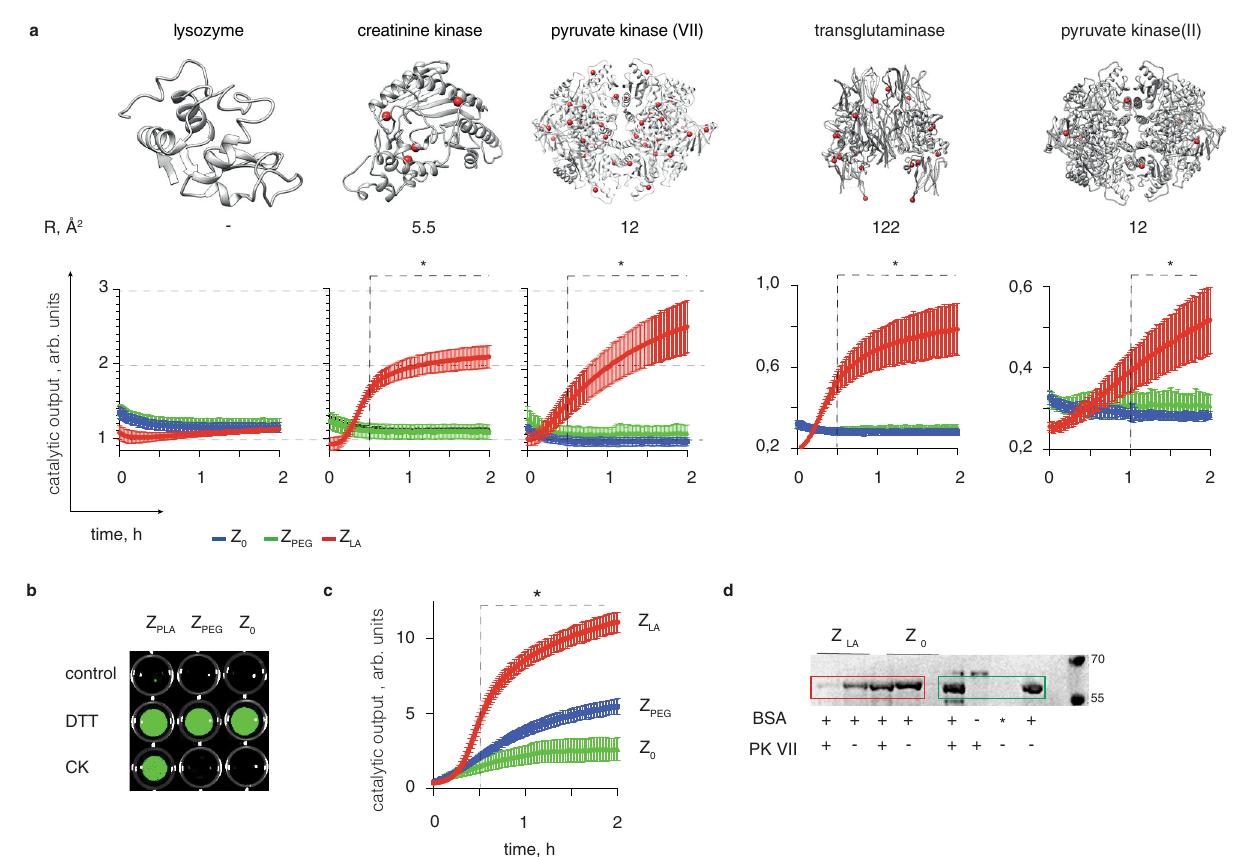
Fig. 4 | Reactivation of zymogens using thiol-containing proteins. a Kinetics of zymogen reactivation using protein activators (25mM borate buffer pH 8, 25mM NaCl, 1mM EDTA; 10 µ M papain, 1 µ M protein activators); for reactivation with creatine kinase and pyruvate kinase VII, concentrations were Z 0 , Z PEG =1 µ M, Z LA = 0.3 µ M; for reactivation with transglutaminase and pyruvate kinase II: Z 0 , Z PEG = 10 µ M, Z LA =3 µ M; protein activators are shown alongside their computed surface accessibilityofthethiols(R,Å 2 ). b , c End-point fl uorescenceimaging( b )andkinetic measurements ( c ) for reactivation of papain zymogens using creatine kinase illustrating that papain activity is masked by the three zymogens and revealed